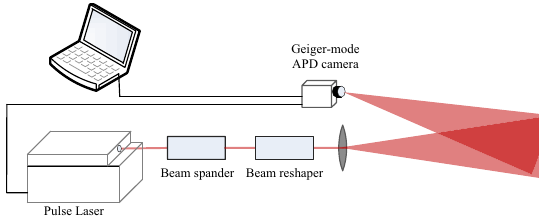
Figure 1 Schematic diagram of the imaging